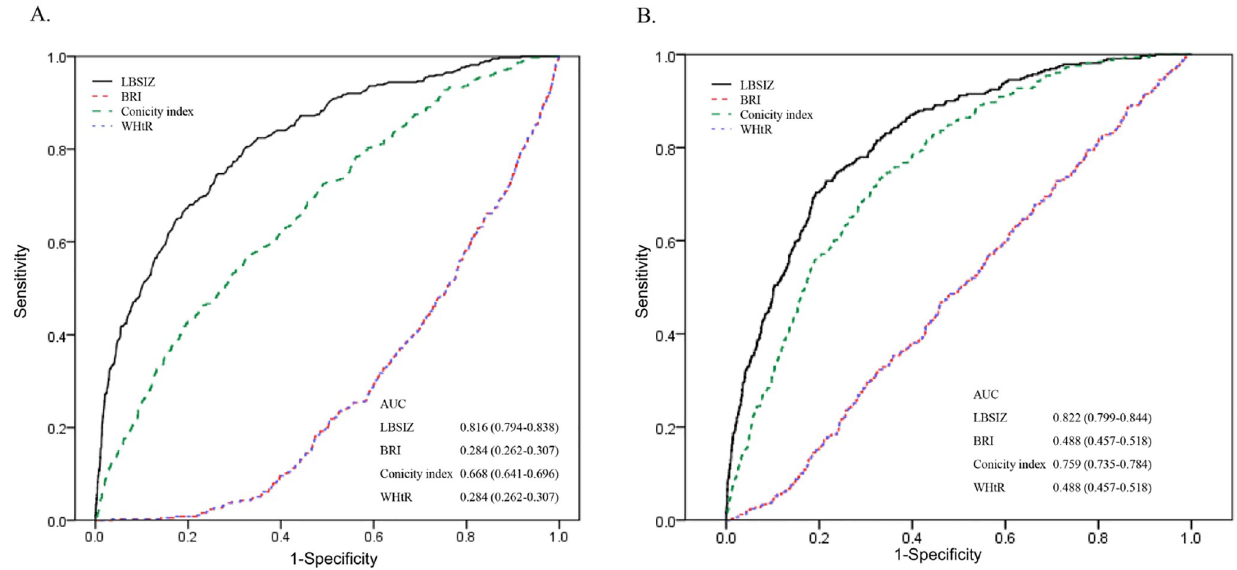
Fig 2. Receiver operating characteristic curves for sarcopenia according to obesity parameters. A. U.S. NHANES; B. KNHANES. LBSIZ, z-score of the log-transformed A Body Shape Index; BRI, Body Roundness Index; WHtR, waist-to-height ratio.